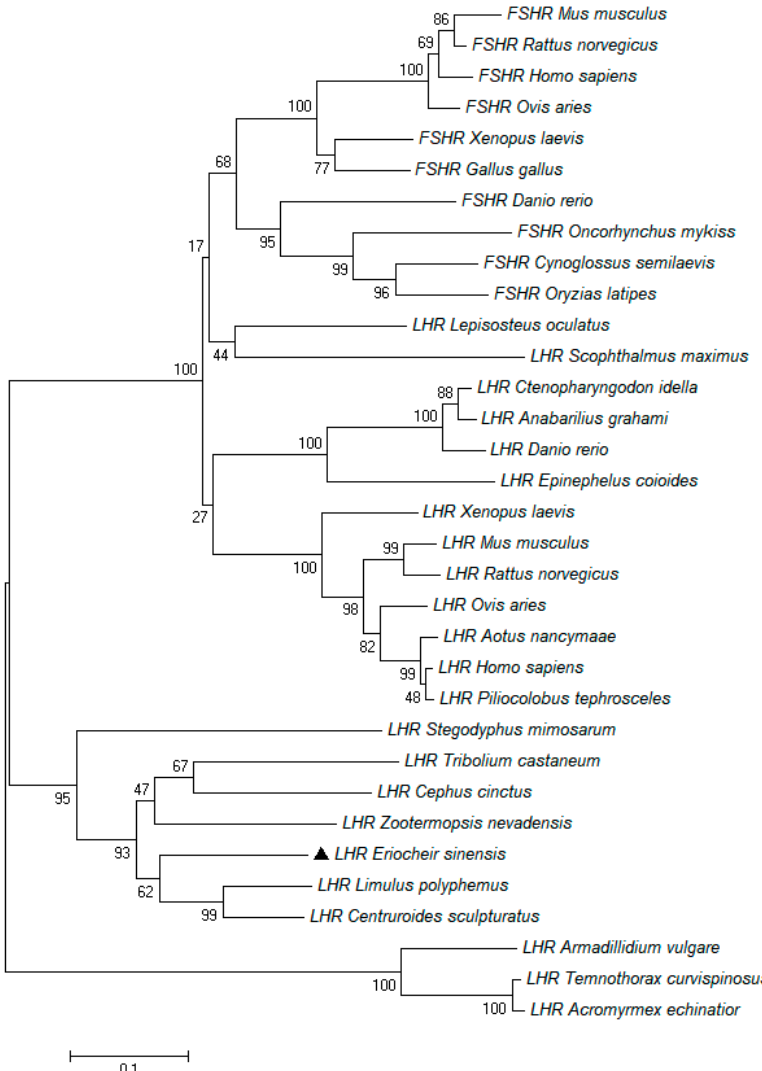
Figure 3. The neighbor-joining phylogenetic tree of EsLHR, and other known G-protein coupled receptor members; alignment of amino acid sequences are produced by Clustal X and MEGA 6.0. The confidence in each node is assessed by 1000 bootstrap replicate. GeneBank accession numbers of above various species: Lepisosteus oculatus LHR (XP_015218187.1); Scophthalmus maximus LHR (AIE47234.1); Anabarilius graham LHR (ROL48811.1); Aotus nancymaae LHR (XP_012320900.1); Pilicolobus tephrosceles LHR (XP_023079591.2); Nephila clavipes LHR (PRD27275.1); Stegodyphus mimosarum LHR (KFM82218.1); Armadillidium vulgare LHR (RXG67696.1); Temnothorax curvispinosus Homo sapiens LHR (CAA59234.1); Ovis aries LHR (NP_001265495.1); Mus musculus LHR